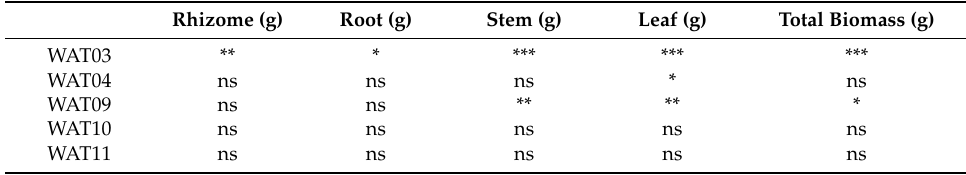
Figure 1. Boxplot of above and below-ground dry matter under control and drought stress treatments ( n = 5). Horizontal, dashed, line is showing the populations average; outliers (which exceeded 2.5 standard deviations) are plotted as individual points. Table 1. Effect of drought stress treatment on biomass accumulation, above and below-ground, separated into leaves, stems, rhizomes, and roots, compared to control; p -value indicates the statistical significance for a given term within the model. Significance of differences are shown as * p ≤ 0.05; ** p ≤ 0.01; *** p ≤ 0.001; ns = not significant.